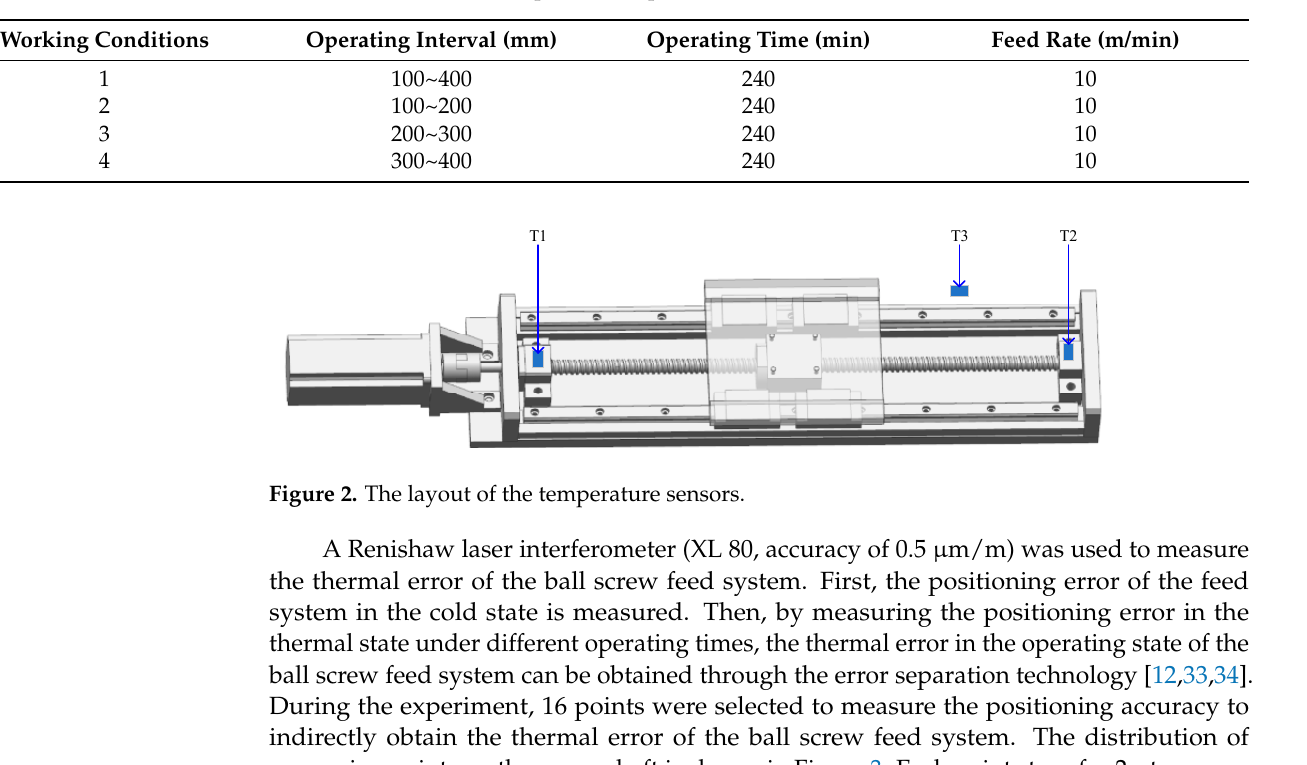
Figure 1. Experimental equipment and experimental schematic diagram: ( a ) Experimental equipment; and ( b ) experimental schematic diagram. Table 3. Experimental parameters.